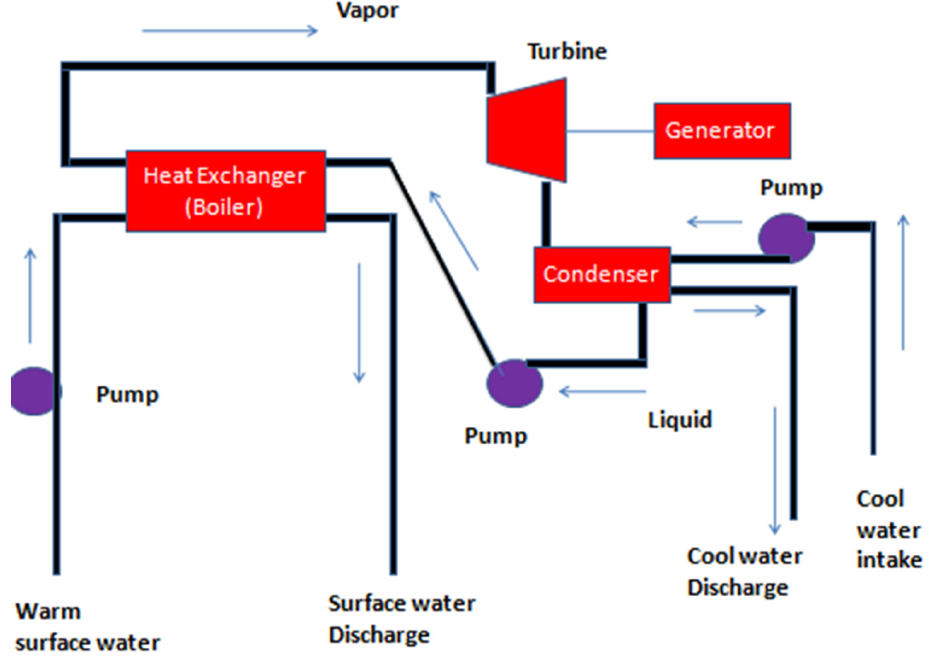
Figure 15. Conceptual diagram of a closed-cycle OTEC system.